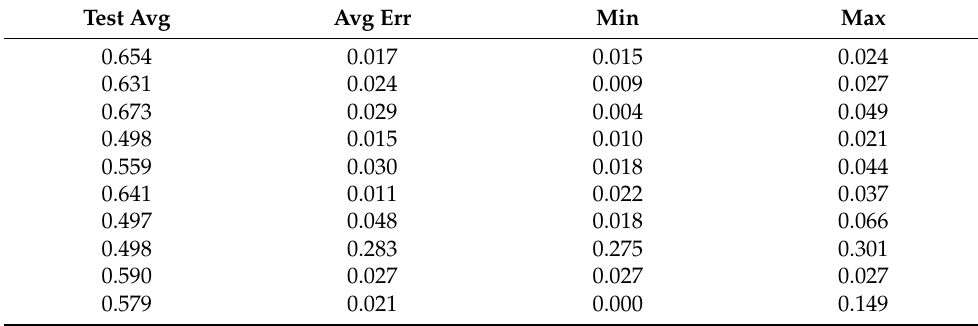
Table A114. Set 2, trials 21–30 data (single 0.5 PR value).